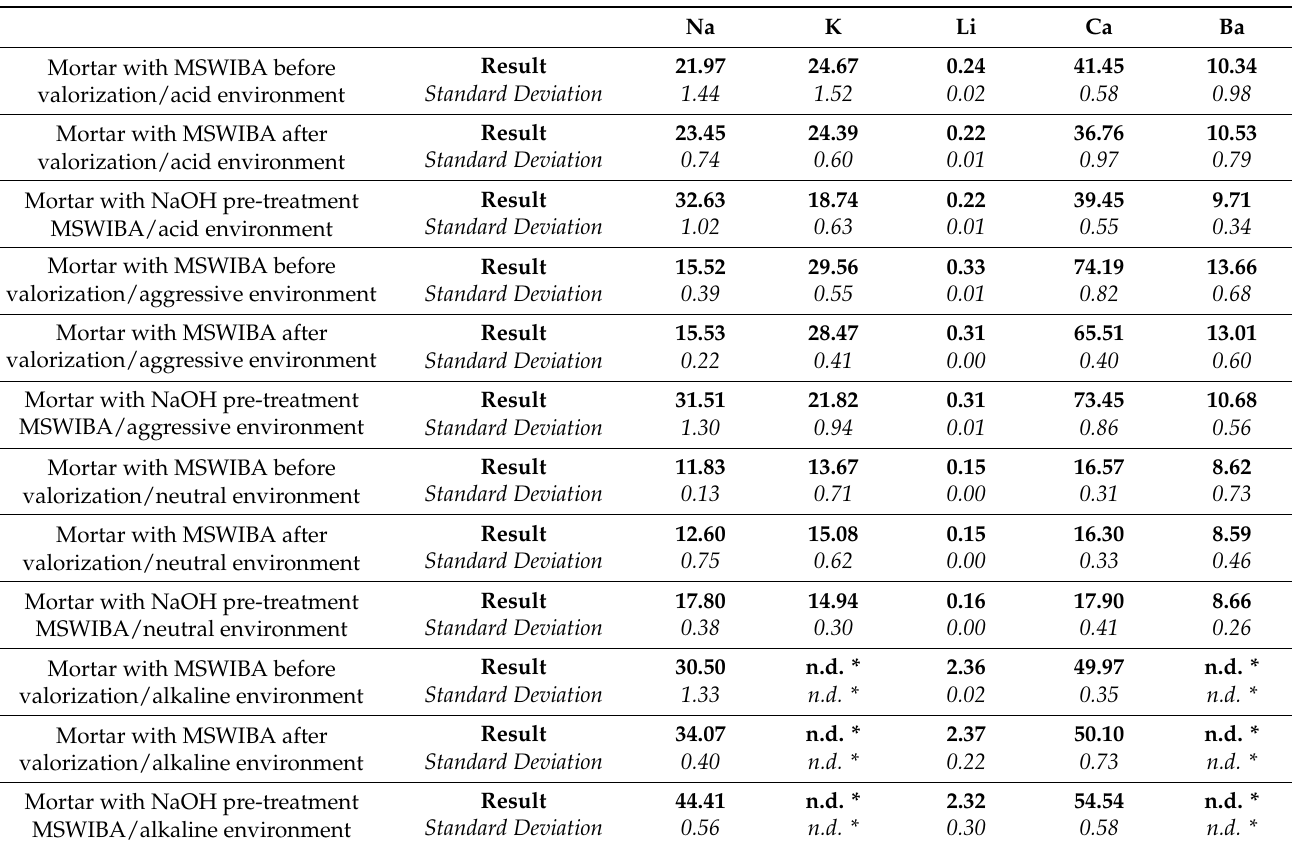
Table 4. Pollution leachability of Na, K, Li, Ca, and Ba from mortars prepared with 30% MSWIBA before or after valorization or after NaOH pretreatment in acidic, neutral, alkaline, and aggressive environments.